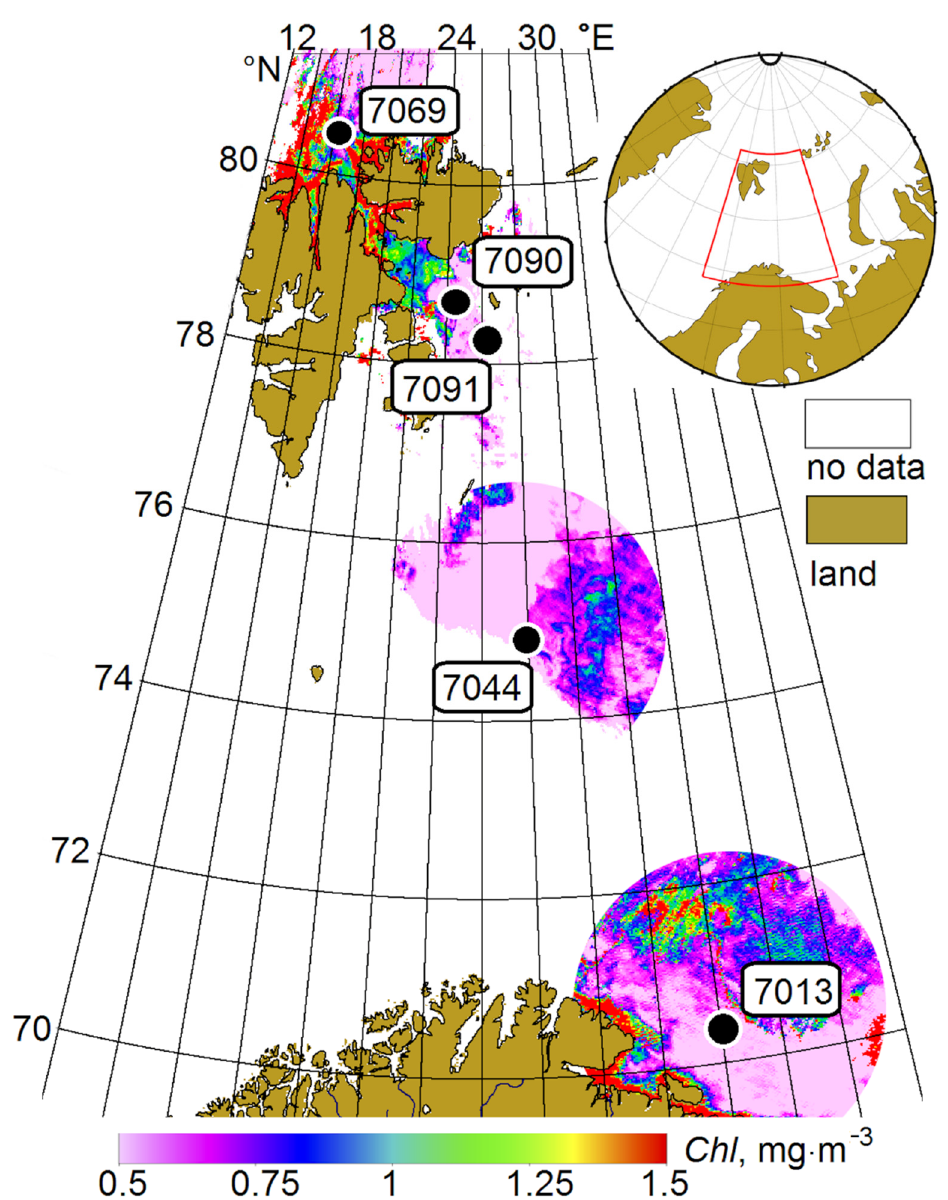
Figure 1. Position of the stations of cruises 83 and 84 of the R/V ‘Akademik Mstislav Keldysh’ against the background of the averaged spatial distribution of chlorophyll-a concentration according to MODIS/Aqua and Terra (chlor_a) data: 7013—12 June 2021; 7044—26 July 2021; 7069—9